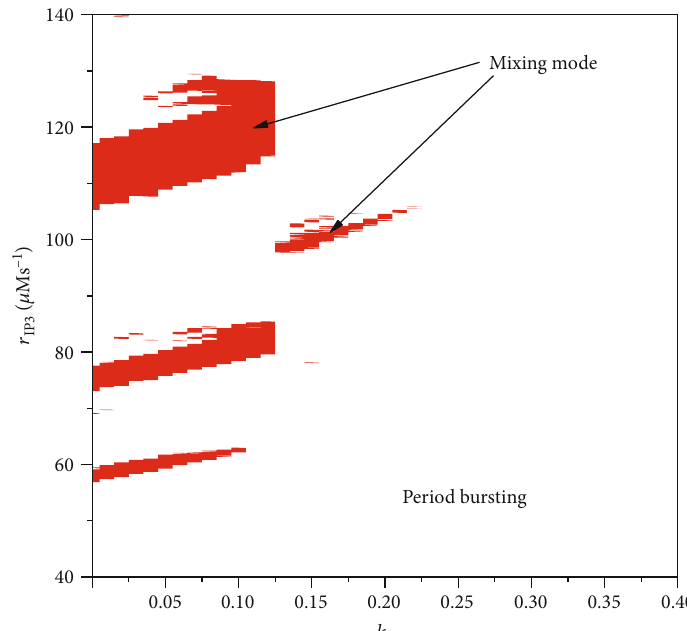
Figure 10: Regions dominated by mixing mode or periodic bursting in parameter space. Red regions denote the mixing mode, and white region is periodic bursting.